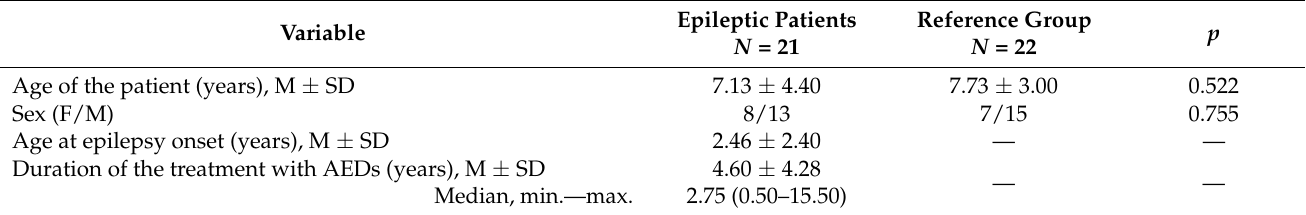
Table 1. General characteristics of the analyzed groups of